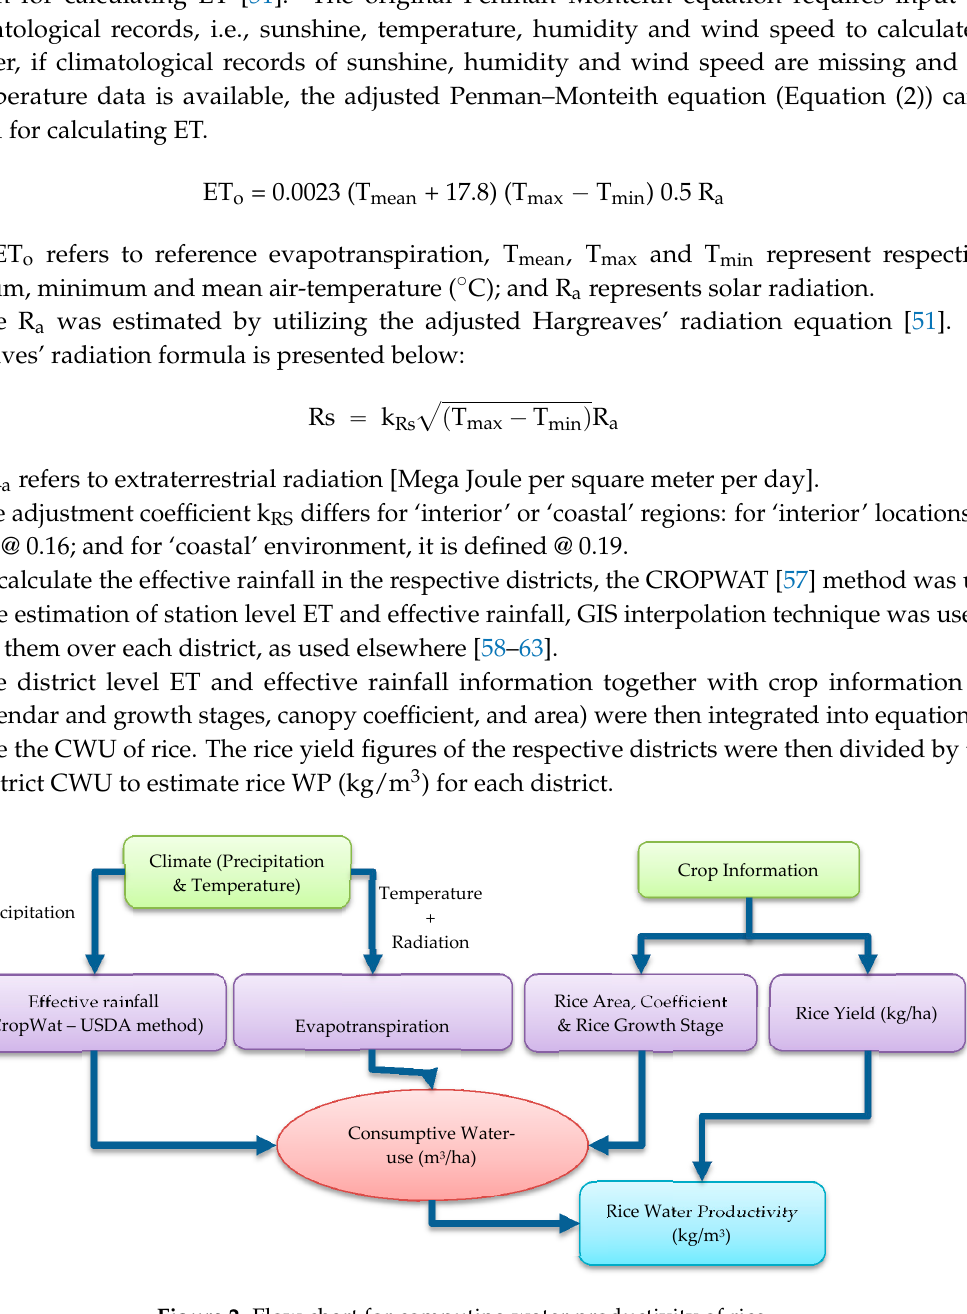
Figure 2. Flow chart for computing water productivity of rice.